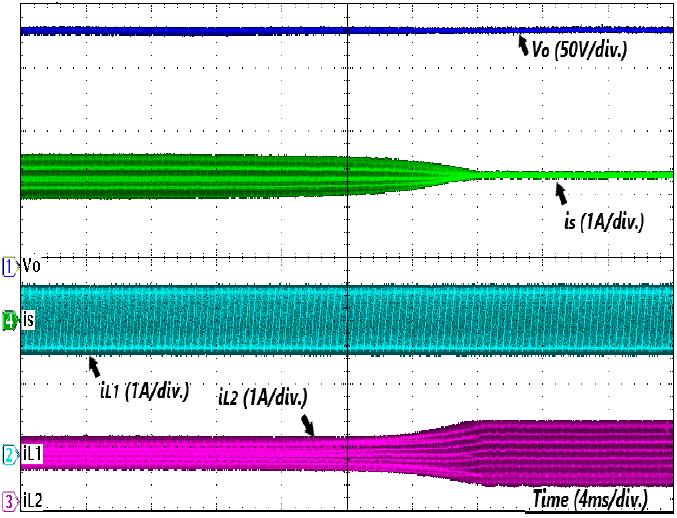
Figure 13. Ripple current in a steady state.